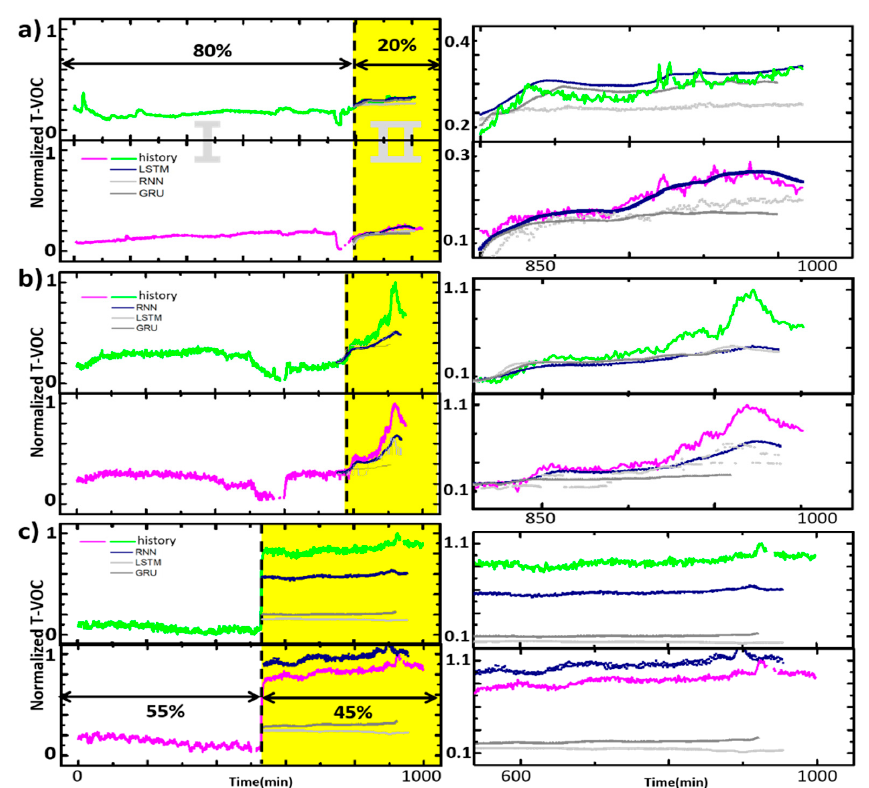
Figure 9. Two sensor data and prediction result on each situation. Region I: train data, Region II: predicted data. Blue line indicates the best prediction method for each situation. It is as ( a ) CONSTANT situation: LSTM (HL:3), while RNN (HL:15)—right gray, GRU (HL:15)—gray, ( b ) EVENT 1 situation: RNN (HL:6) while LSTM (HL:15)—right gray, GRU (HL:15)—gray, ( c )